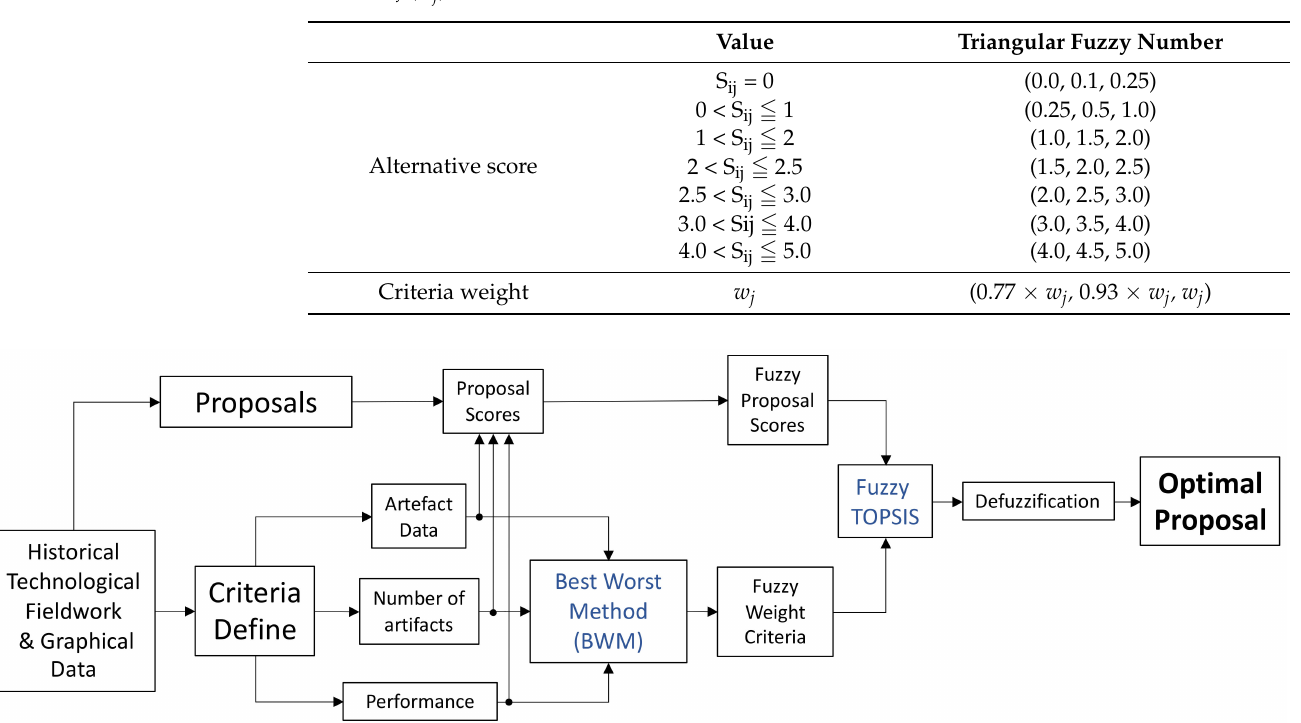
Table 3. Fuzzification of score of alternative i with respect to criterion j (S ij ) and weight of the criterion j ( w j ).